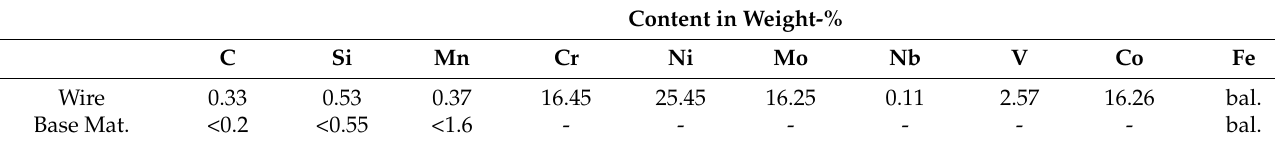
Table 1. Nominal chemical composition of the metal-cored